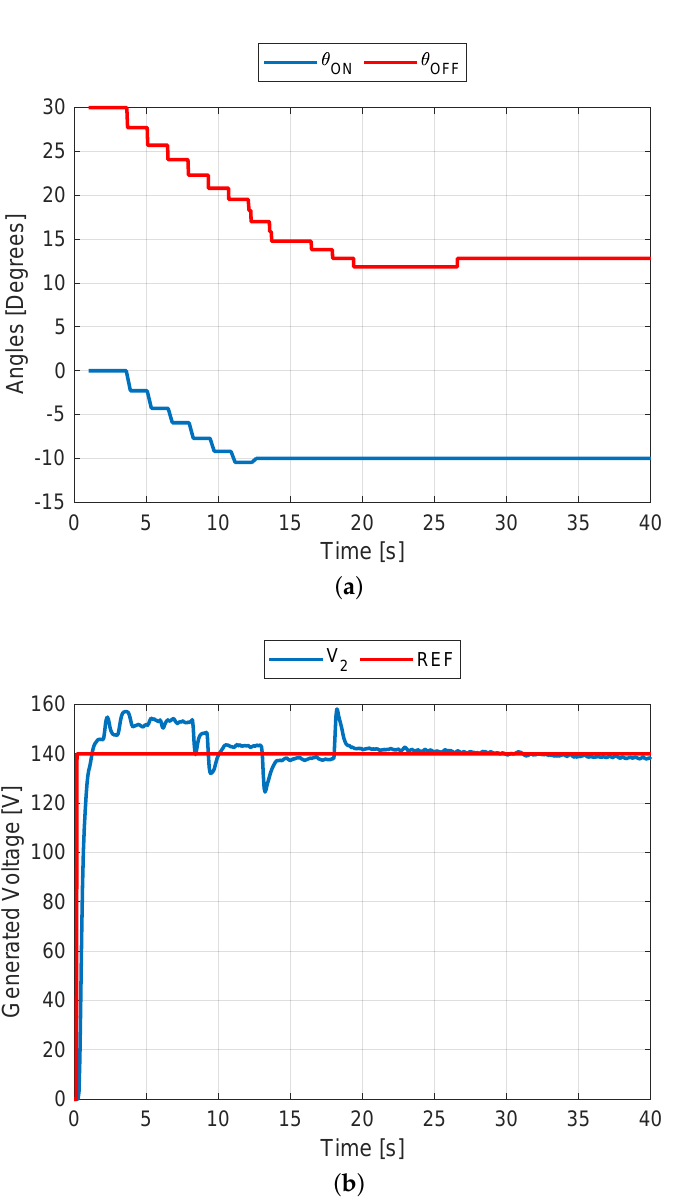
Figure 17. Simulation result for 140 V reference: ( a ) Evolution of angles θ ON and θ OFF with MEPT algorithm: ( b ) Performance of voltage controller in parallel with MEPT